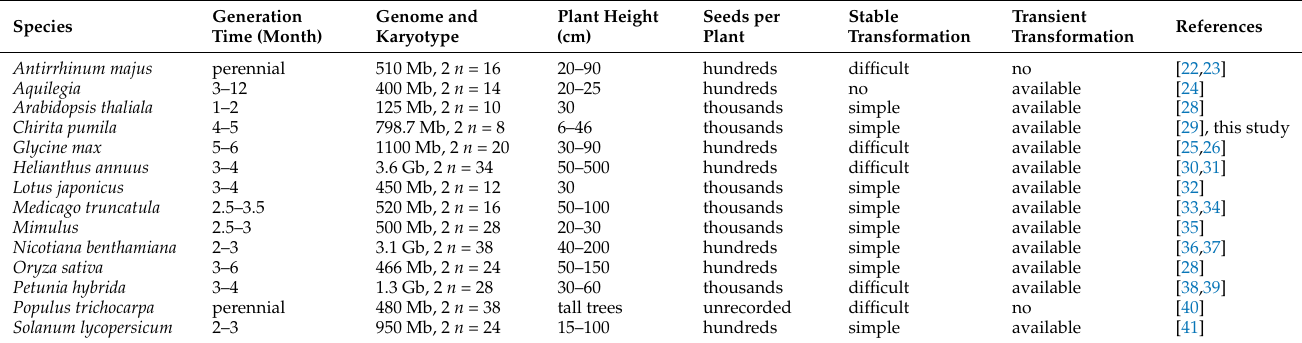
Table 1. Comparison among representative model